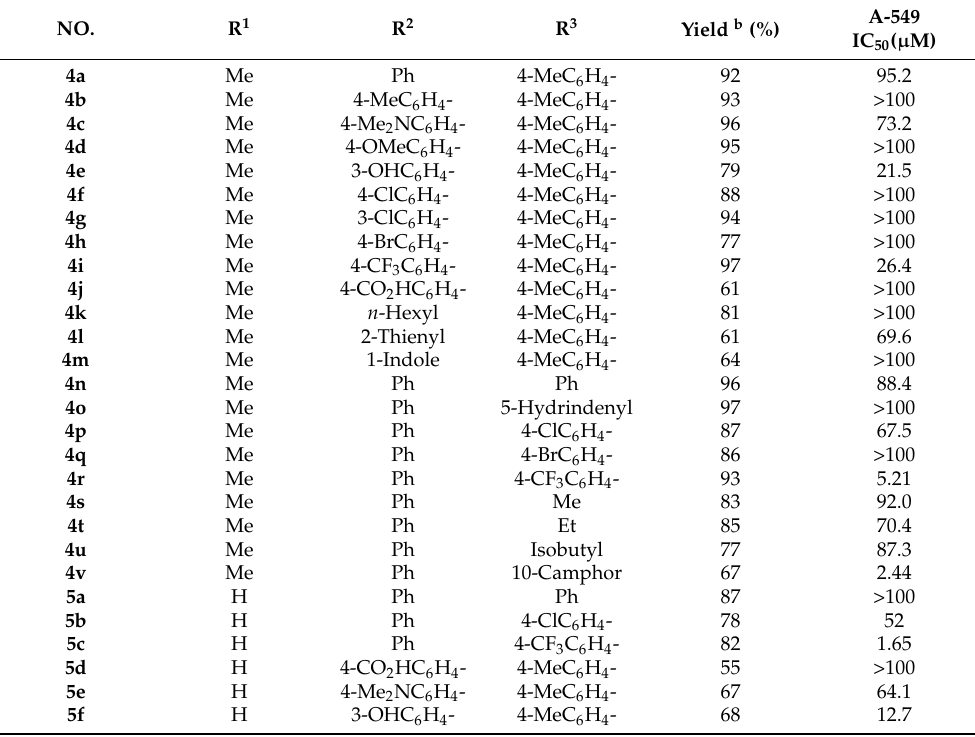
Table 1. The in vitro anti-proliferative activities (IC 50 , µ M) a of compounds 4a – 4v and 5a – 5f . NO. R